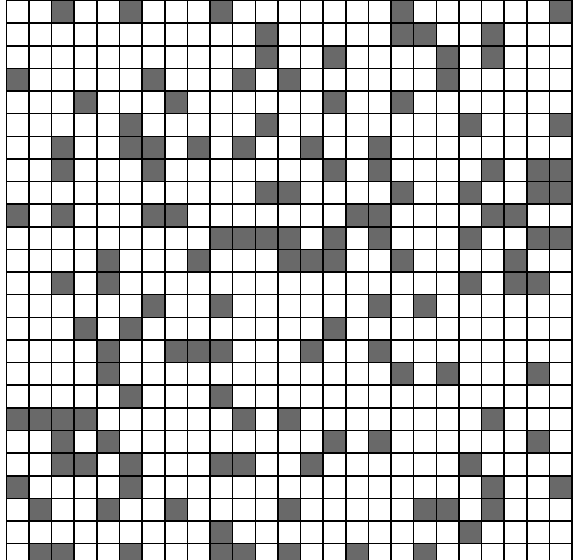
Figure 5. Original data